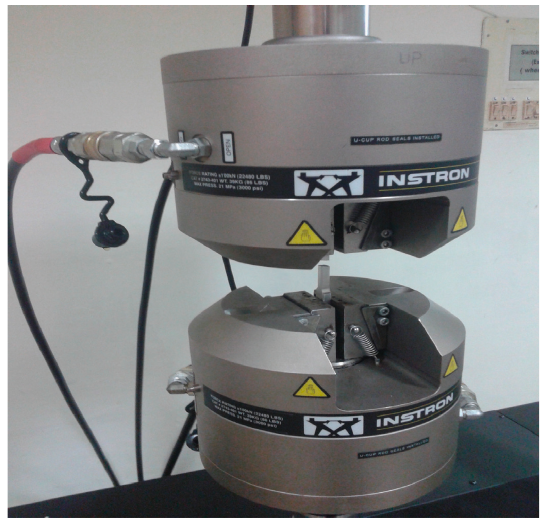
Figure 1: Tensile testing